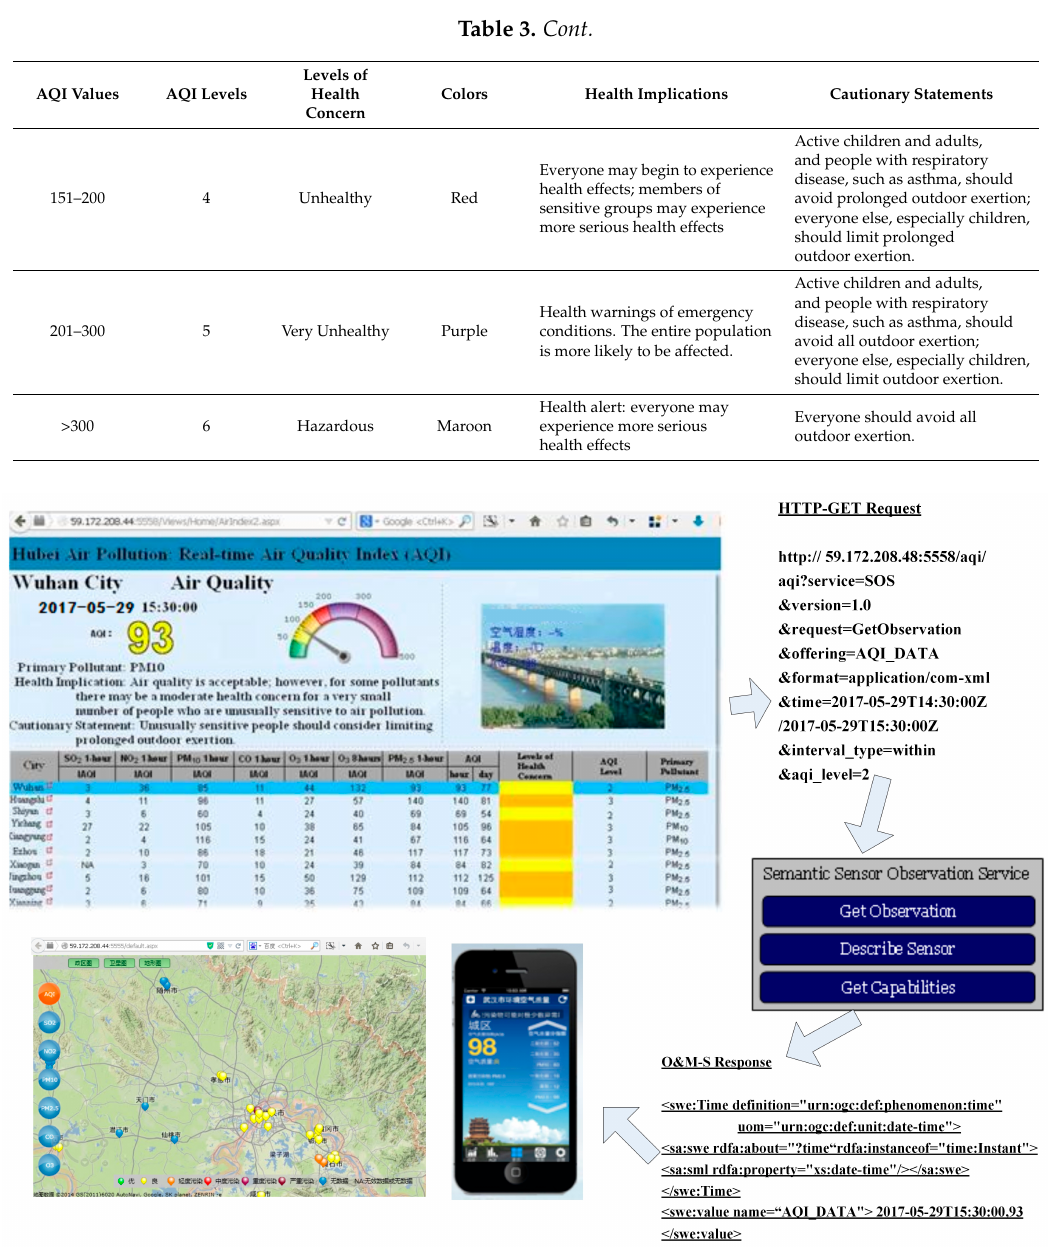
Figure 9. Prototypes of the S-SOS agent for publishing air quality.